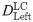
Disparity results in the cell map layers for the tsukuba [27] stereo pair.
(a): Tsukuba’s left view. (b): Ground-truth. (c): D
L (L-DEM) result. (d): Bad pixels (black) with an absolute disparity error ≥ 0.5 and (e): signed disparity error returned by the Middlebury evaluation test [8]. (f): Left–viewpoint DLeftLC. (g): Centre–viewpoint DCentreLC. (h): Right–viewpoint DRightLC. (i): Left-viewpoint corrected D^LCV. (j): Background and occlusion corrected D
LCV. (k): Line and edge region enhanced D^LCVE. (l): Object border enhanced D
LCVE. (m): The final disparity map D
LCVB, after median smoothing. (n): Bad pixels (black) with absolute disparity error ≥ 0.5. (o): Signed disparity error of D
LCVB. Images (a) and (b) are reprinted from [26] under a CC BY license, with permission from Daniel Scharstein, original copyright 2002.